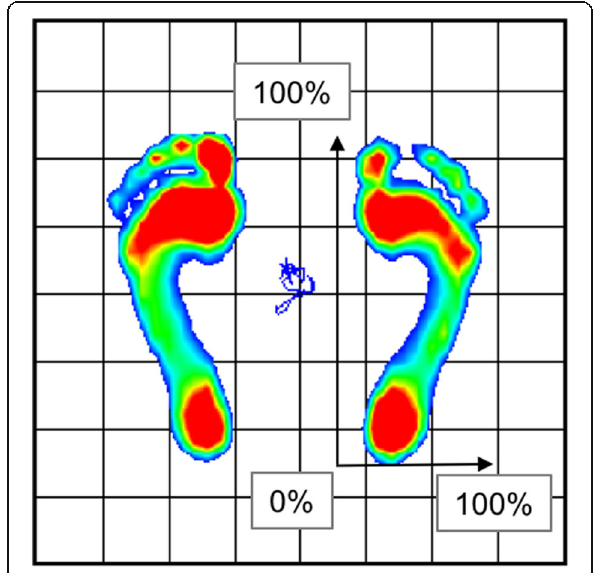
Fig. 5 Distribution of plantar pressure. P-A of 0% is the posterior end of the heel and M-L of 0% is the medial end of the foot